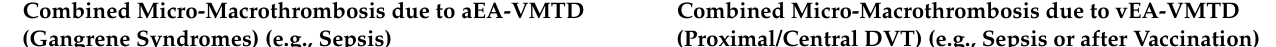
Table 4. Diagnostic clinical and laboratory findings due to combined micro-macrothrombosis in aEA-VMTD and vEA-VMTD. Combined Micro-Macrothrombosis due to aEA-VMTD (Gangrene Syndromes) (e.g.,